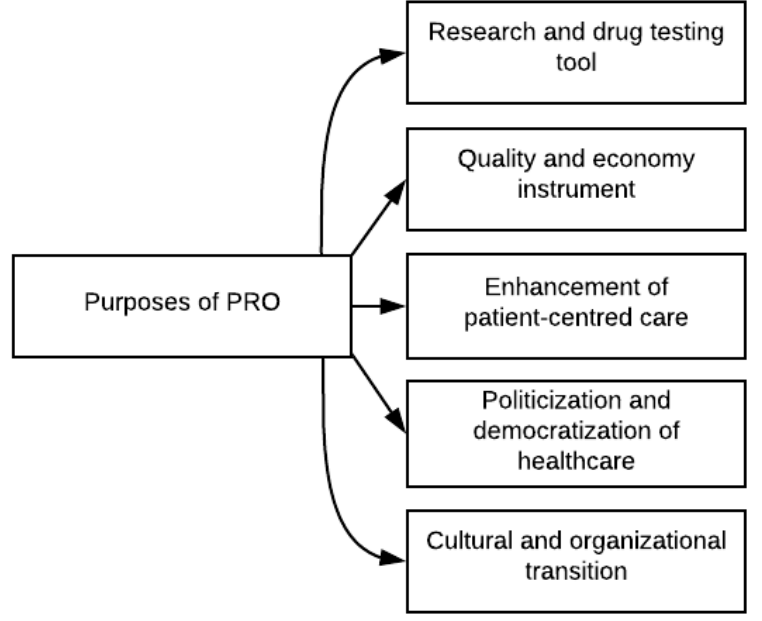
Figure 1. Identified purposes of Patient-Reported Outcome (PRO).